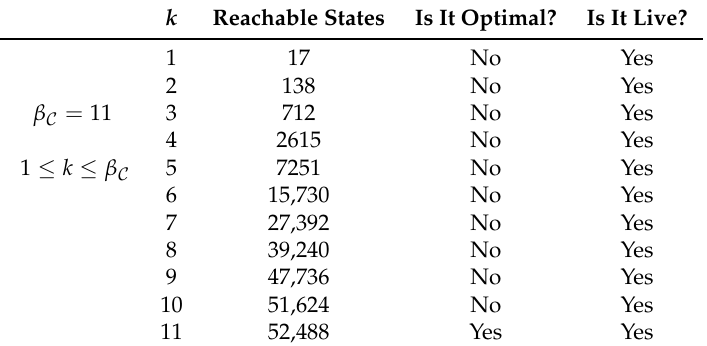
Table 4. Behaviour of the controlled Petri net model from the minimal to maximum initial marking.